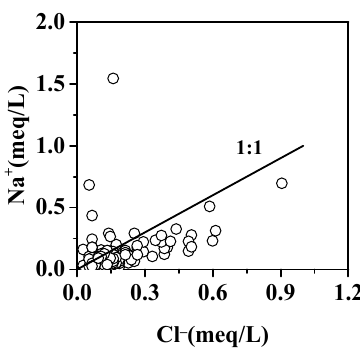
Figure 7. Plots of Na + and Cl − in groundwater samples.